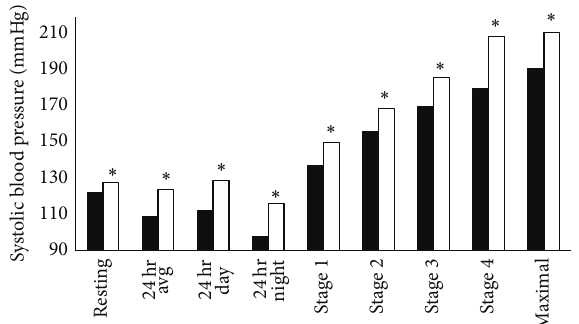
Figure 1: Comparison of systolic blood pressure levels between control (solid bars) and football players (open bars). Significance: ∗ 𝑃 < 0.05 compared to control group.